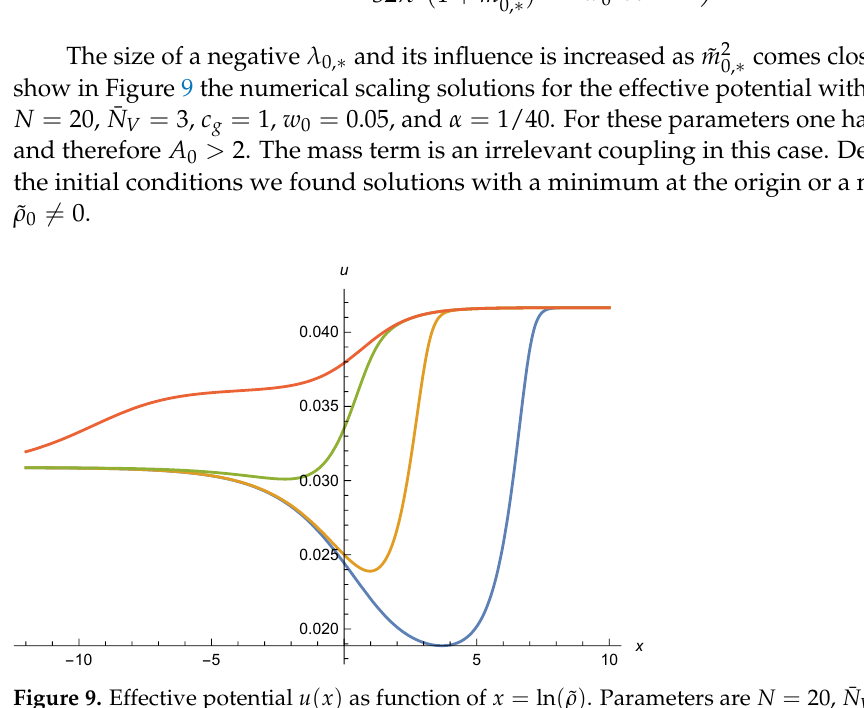
Figure 9. Effective potential u ( x ) as function of x = ln ( ˜ ρ ) . Parameters are N = 20, ¯ N V = 3, c g = 1, w 0 = 0.05, and α = g 2 / 4 π = 1/40. The initial conditions for the four curves from up to down are u ( x = 0 ) = 0.037923, u ( x = 0 ) = 0.0335, u ( x = 0 ) = 0.25, and u ( x = 0 ) = 0.24447. The initial values for the upper and lower curves limit the interval for which a scaling solution is found. For these solutions one has A 0 =